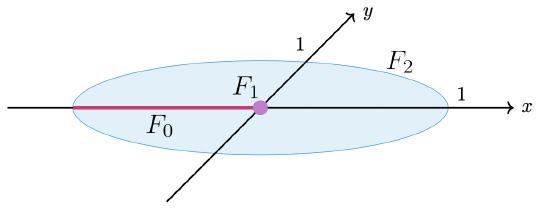
Figure 5. Domains where the different R-symmetry channels are known analytically from the perturbative computation at next-to-leading order. Here z := x + iy . The 2 -channel is known everywhere, the 0 -channel is known only on the line z = ¯ z =: x for x ≤ 0 , while the 1 -channel is known only at one